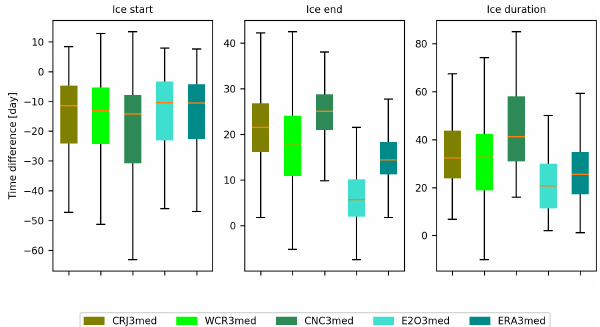
Figure 6. Boxplot of the model errors on the start, end and dura- tion of the ice period for the five simulations CJR3med, WCR3med, CNC3med, E2O3med and ERA3med. Median values are repre- sented by orange lines, and quartiles by the edges of the color